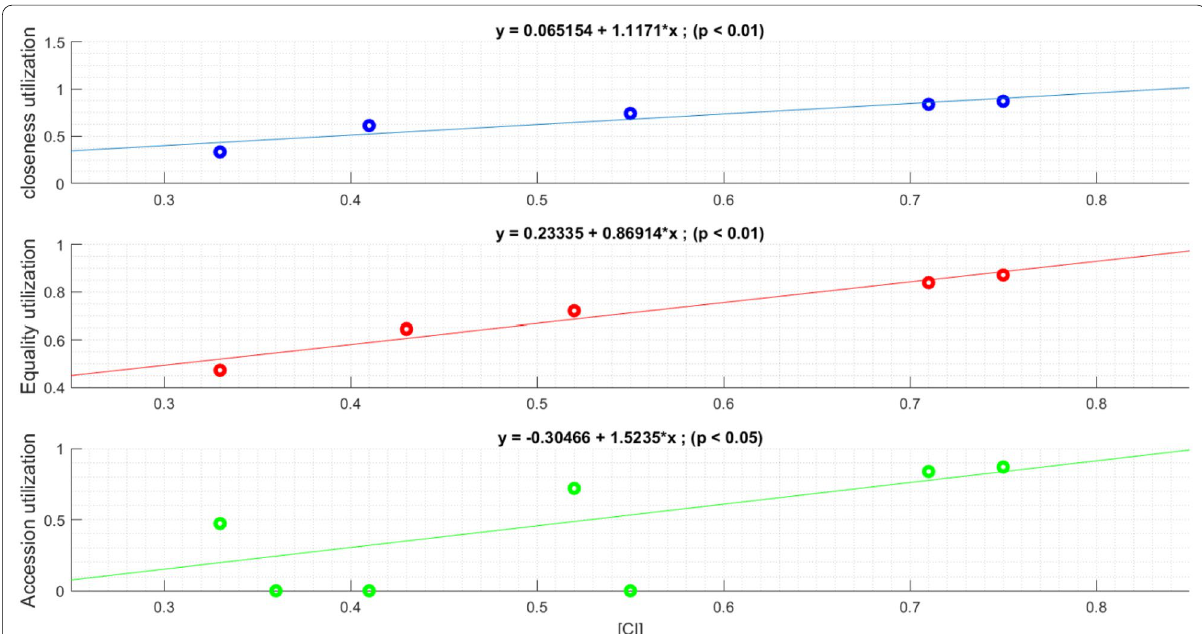
Fig. 2 The relationship between CI and the frequency of implementation of the selection